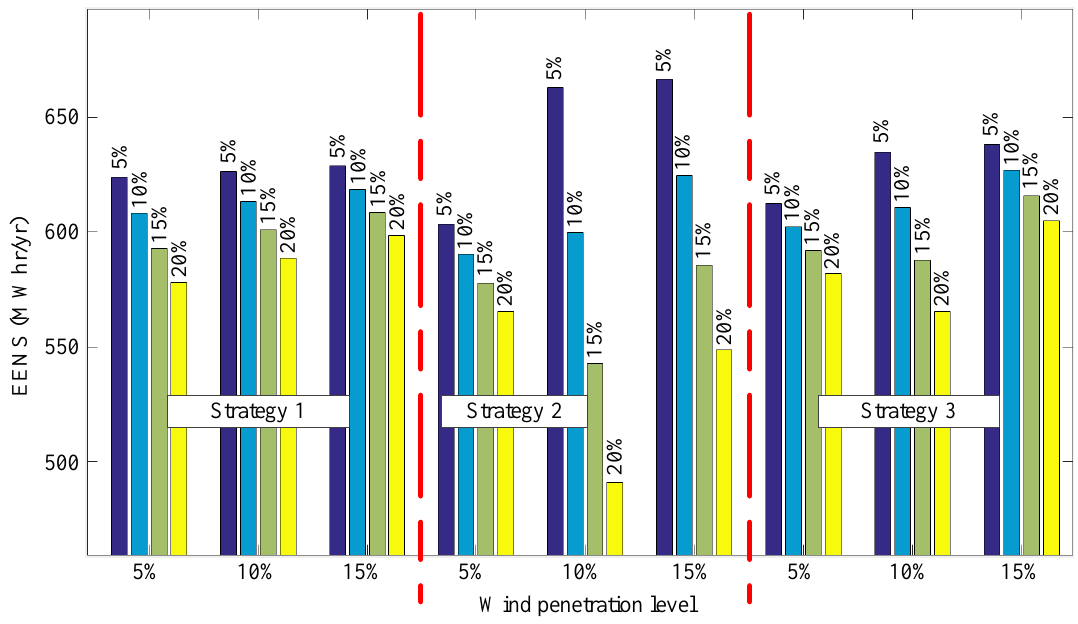
Figure 4. Effects of the BESS capacity (DR 70% load curve).